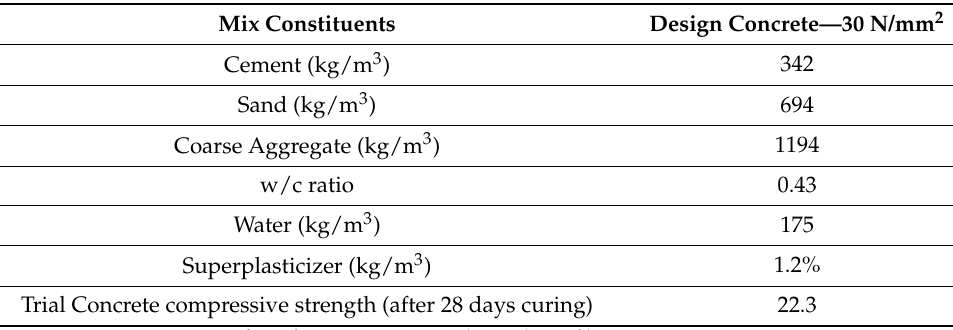
Table 3. Basic concrete proportions used in the experimental study.